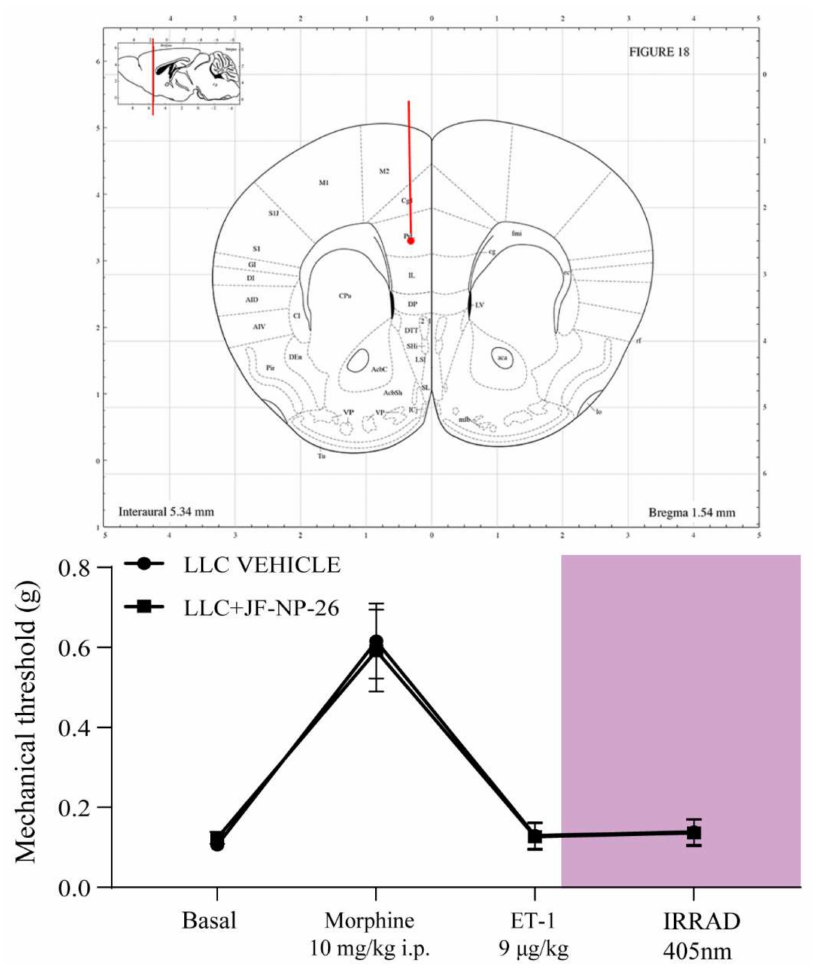
Figure 4. Light-induced activation of JF-NP-26 in the prelimbic cortex failed to induce analgesia in BTcP mice. Mice were treated as in Figure 3, with the difference that irradiation was performed bilaterally in the prelimbic cortex. Values are means ± S.E.M. of 10 mice per